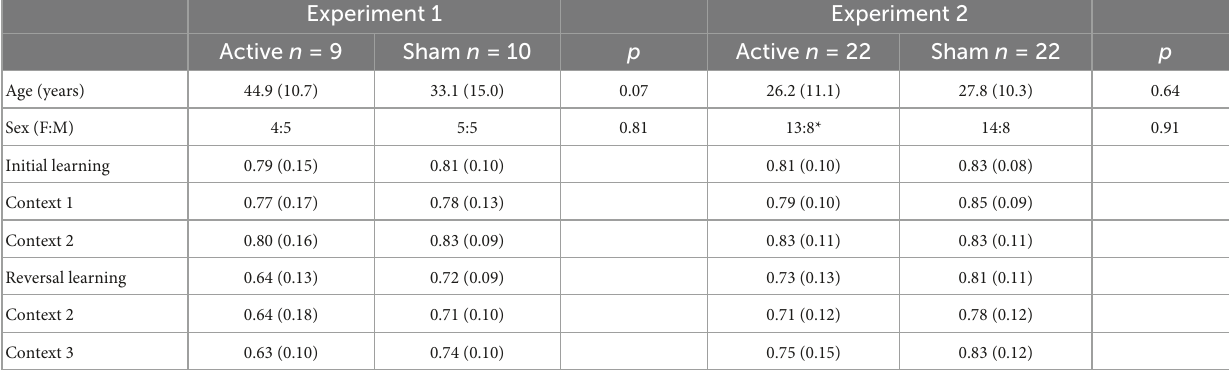
TABLE 1 Demographics and mean accuracy (standard deviation) across initial and reversal learning trials and contexts for Experiment 1 and 2.